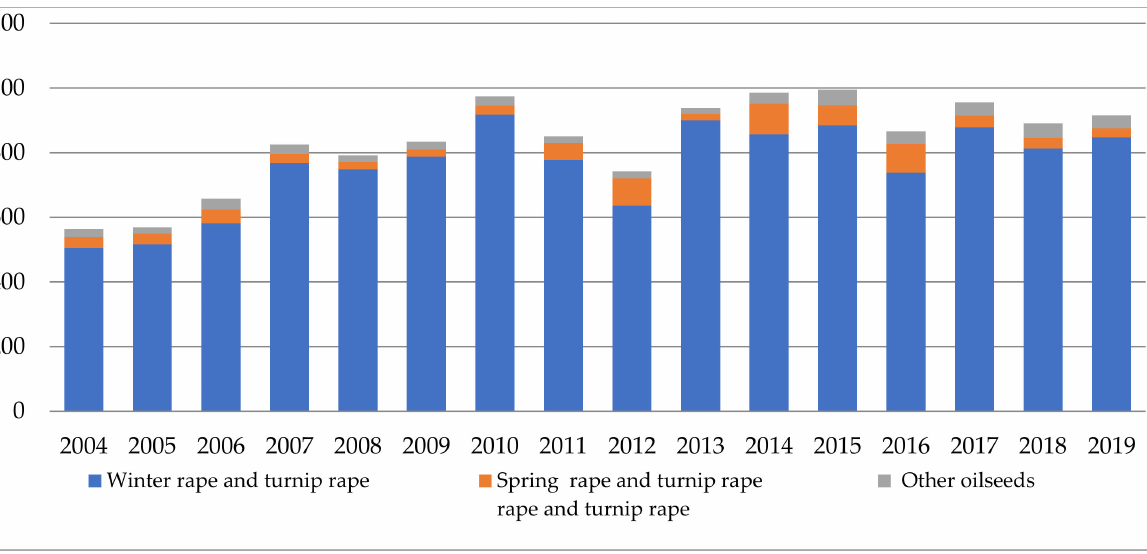
Figure 2. Sown area of oilseed crops in Poland in 2004–2019 (per thousand hectares). Table 3. Linear trend models for the sowing of major crops and selected biofuels and their statistical characteristics. Scheme